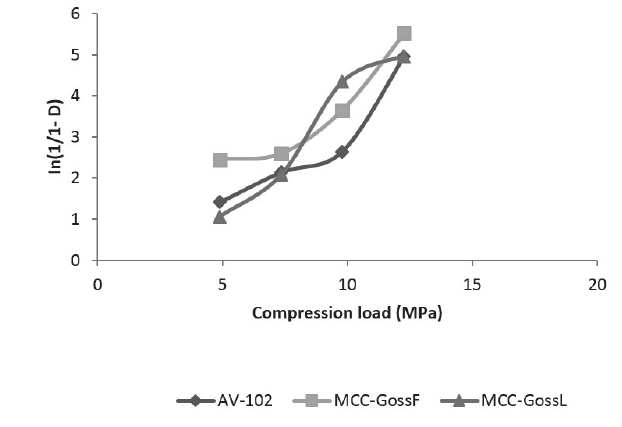
FIGURE 6 - Heckel plot of MCC-GossF, MCC-GossL and AV- 102 .